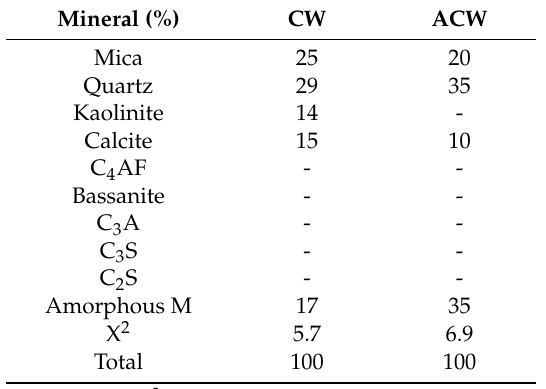
Table 2. Rietveld-refined mineralogical composition of crystalline phases.